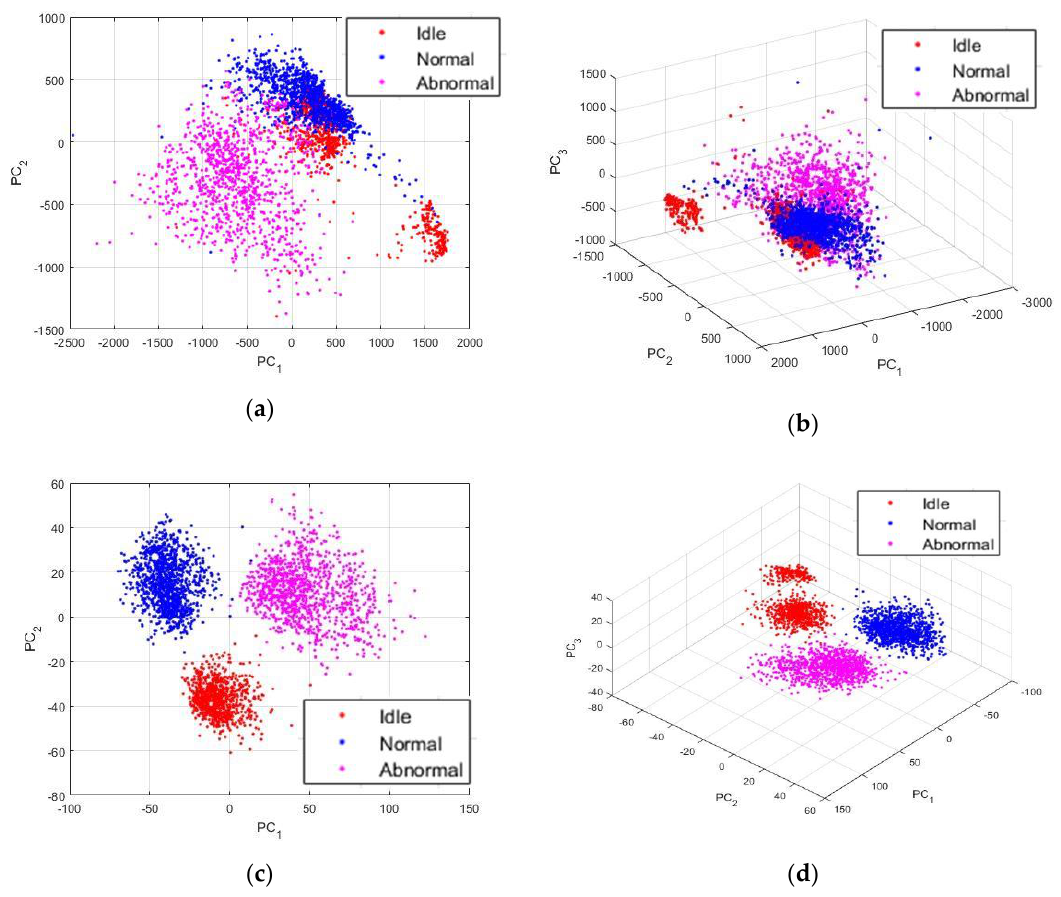
Figure 14. Visualization of the low-level features learned by the DCAE in a two-dimensional (2-D) ( a ) and three-dimensional (3-D) ( b ) view. Visualization of the high-level features in a 2-D ( c ) and 3-D ( d ) view. There 2993 data in the